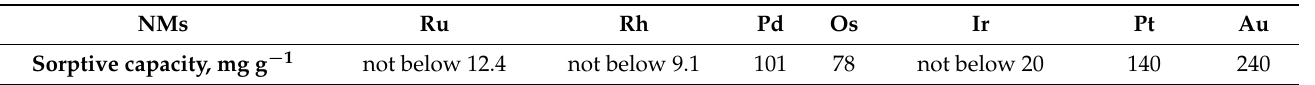
Table 5. The experimental sorptive capacity of PVBC-VP sorbent for NMs in 0.2–1.0 M HCl-containing